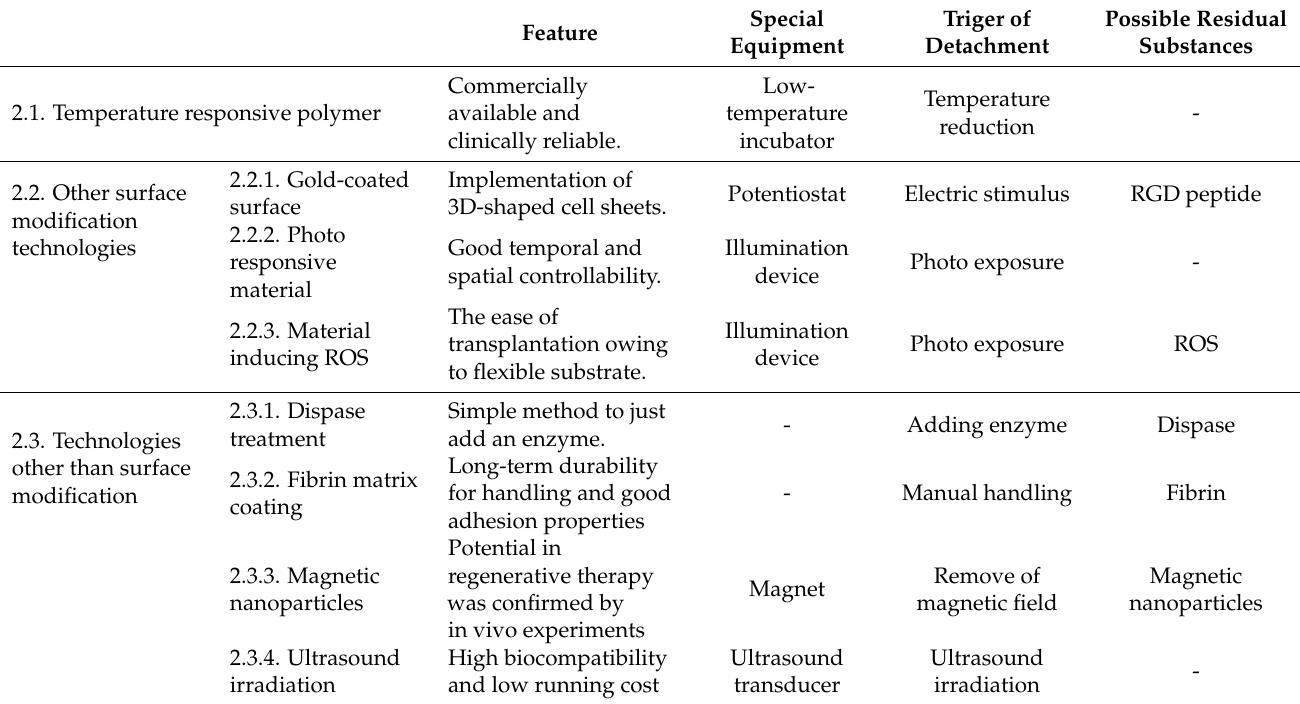
Table 1. The features of each